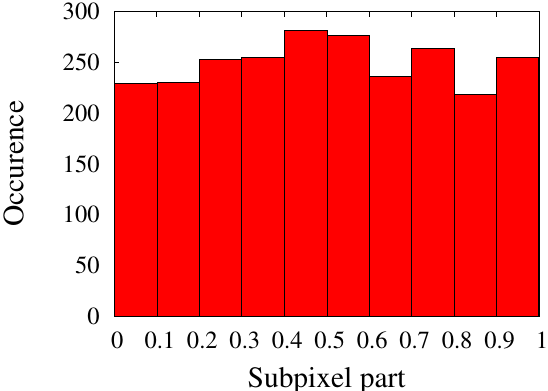
Figure 3. Distribution of subpixel displacement.